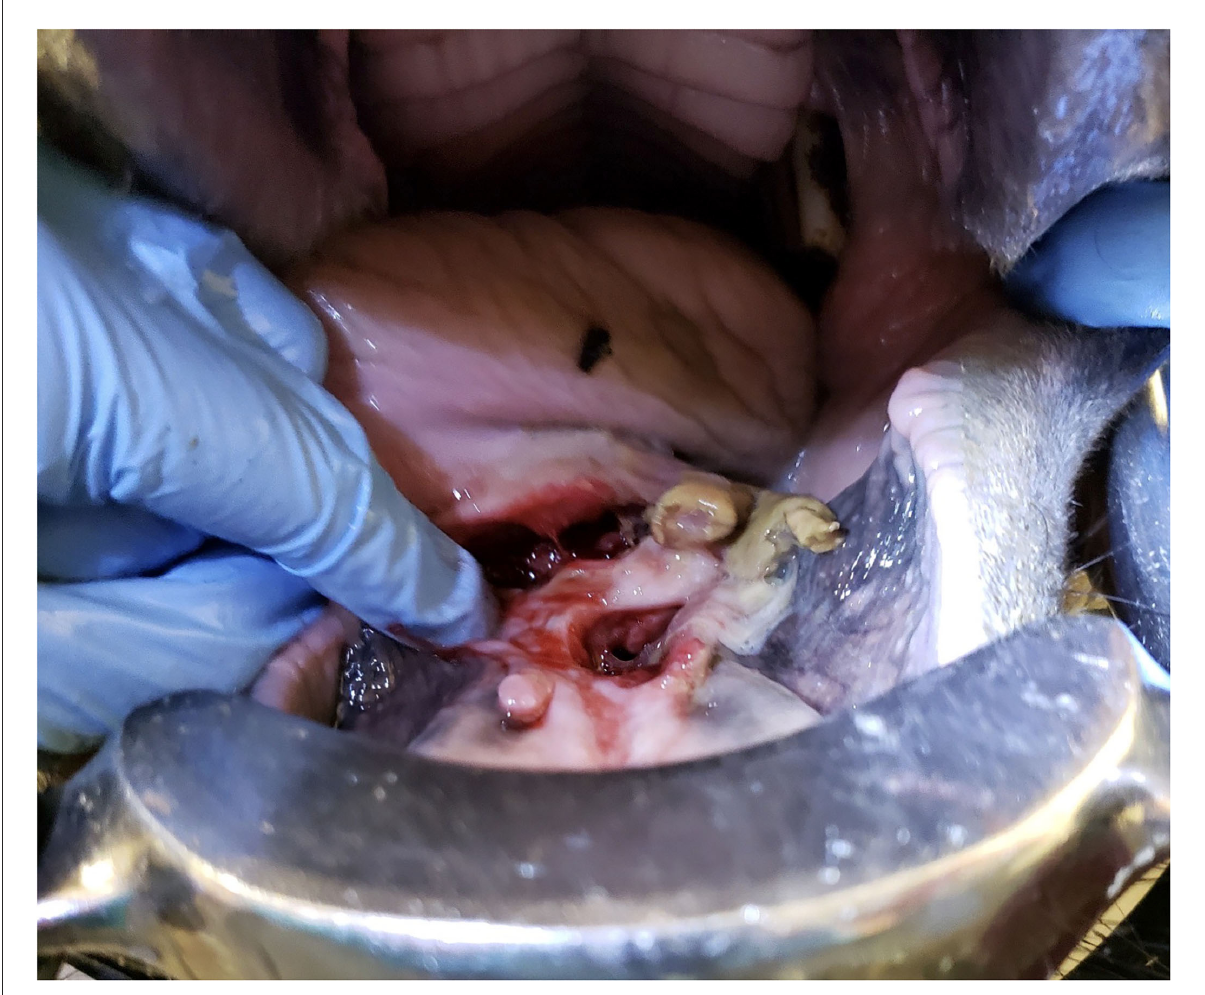
FIGURE2 Image of the intra-oral lesion on day 11 (treatment day 2) after initial